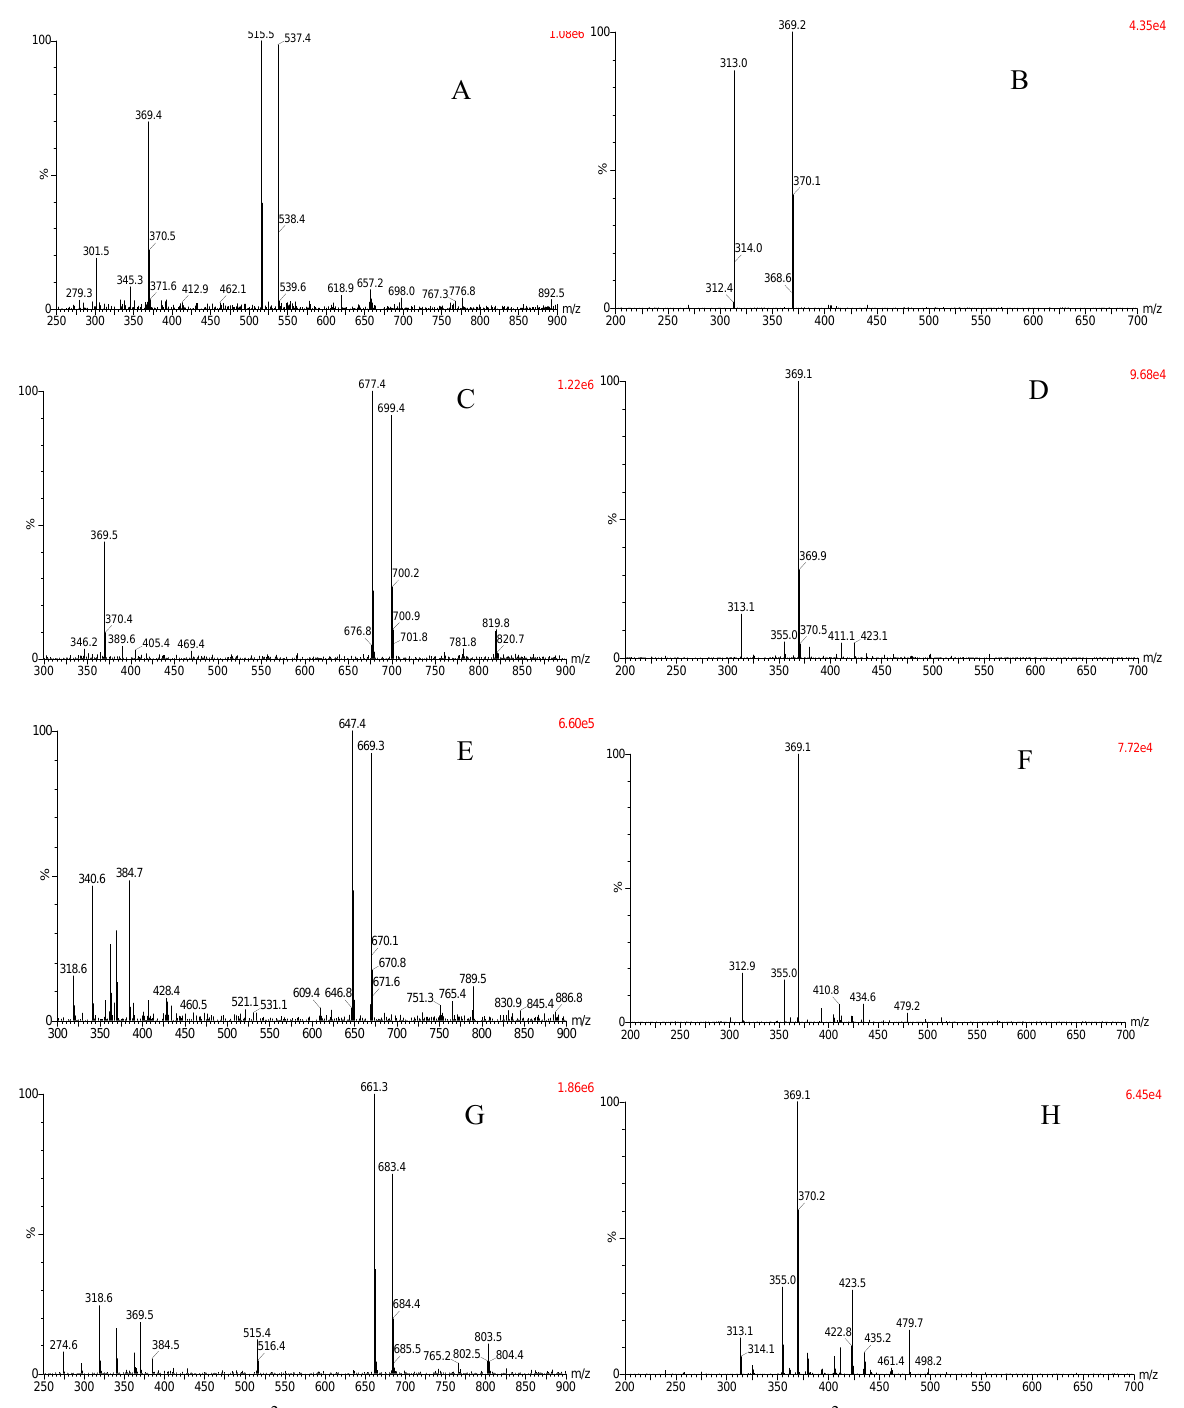
Figure 5. MS n spectra corresponding to the metabolite peaks of prenylflavonoids